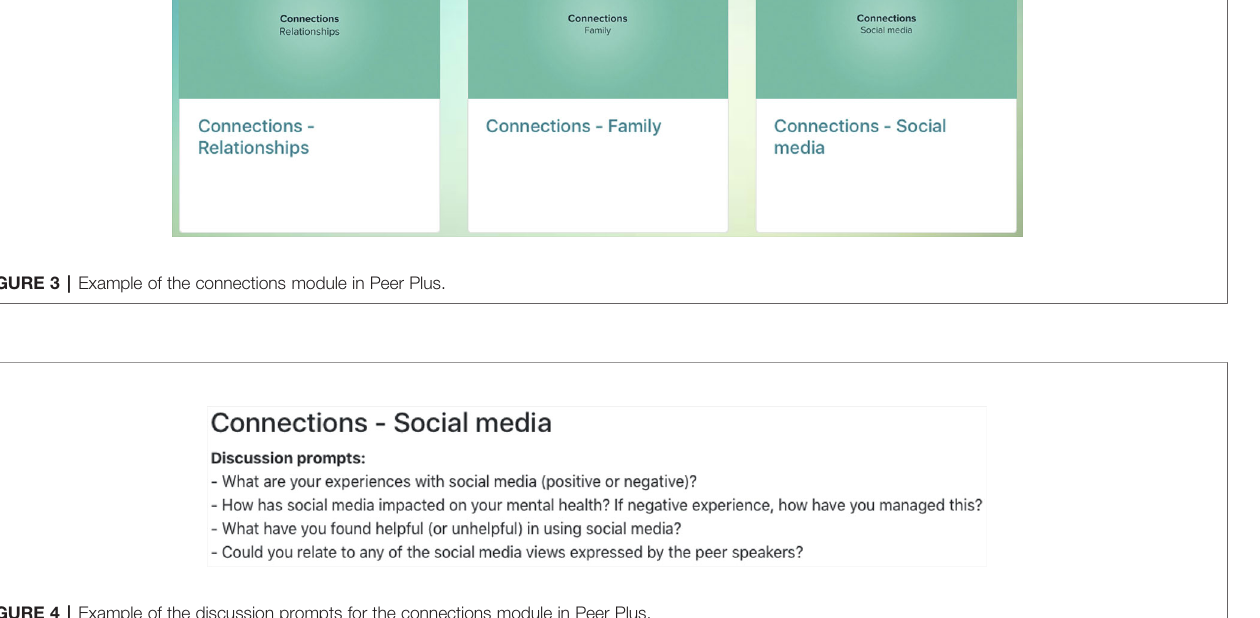
FIGURE 4 | Example of the discussion prompts for the connections module in Peer Plus.